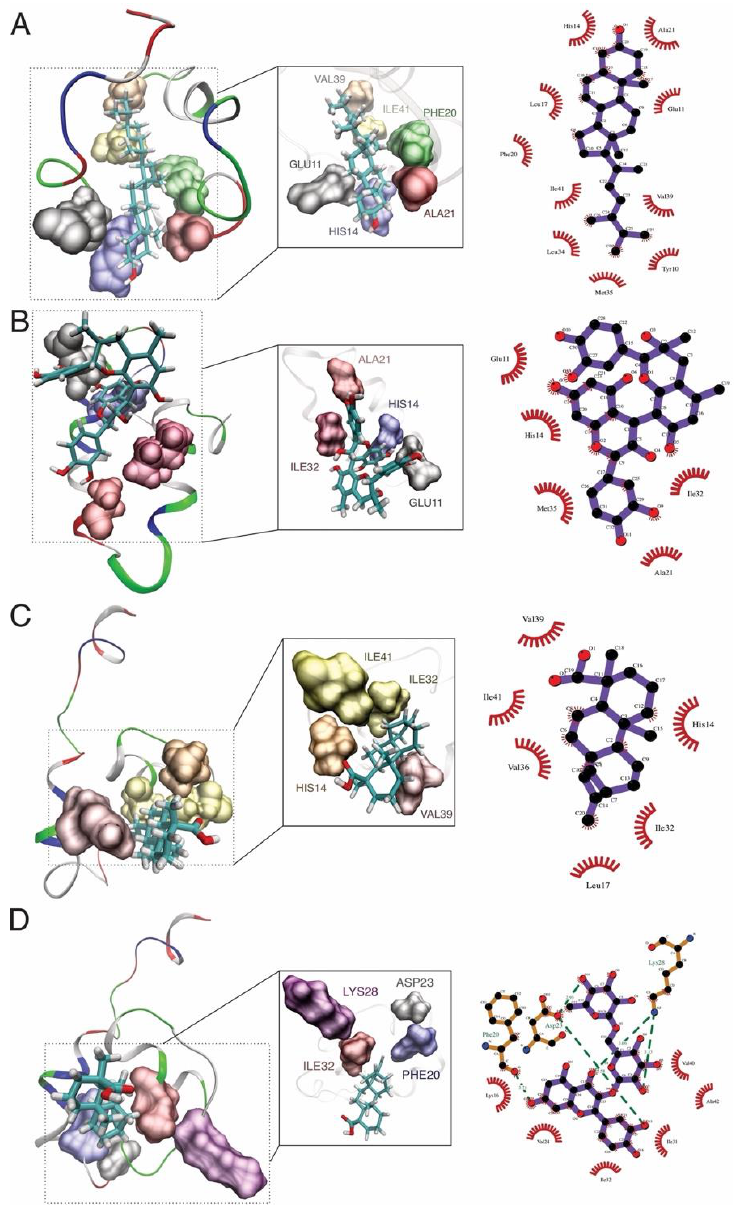
Figure 4. MD simulation and docking analysis shows the formation of hydrogen bond interactions between the amyloid beta and: ( A ) brassicasterol, ( B ) grapeseed extract, ( C ) kaurenoic acid, and ( D ) rutin binding interactions between the ligand and receptor. (GLN351), ILE360, and THR361 as common interacting residues (Figure 5). In fact, the